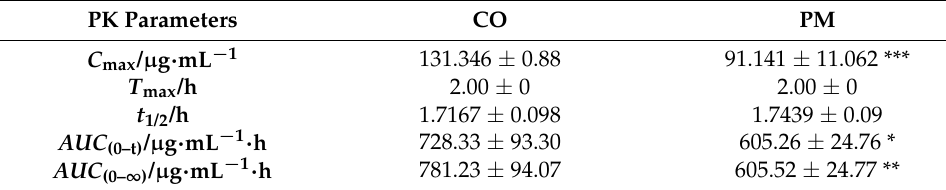
Table 1. Pharmacokinetic parameters of SIM in the CO or